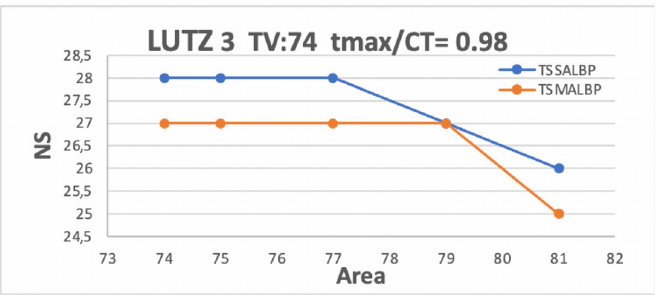
Figure 5. The number of stations drawn against the area for Lutz 3 instance with high TV and T